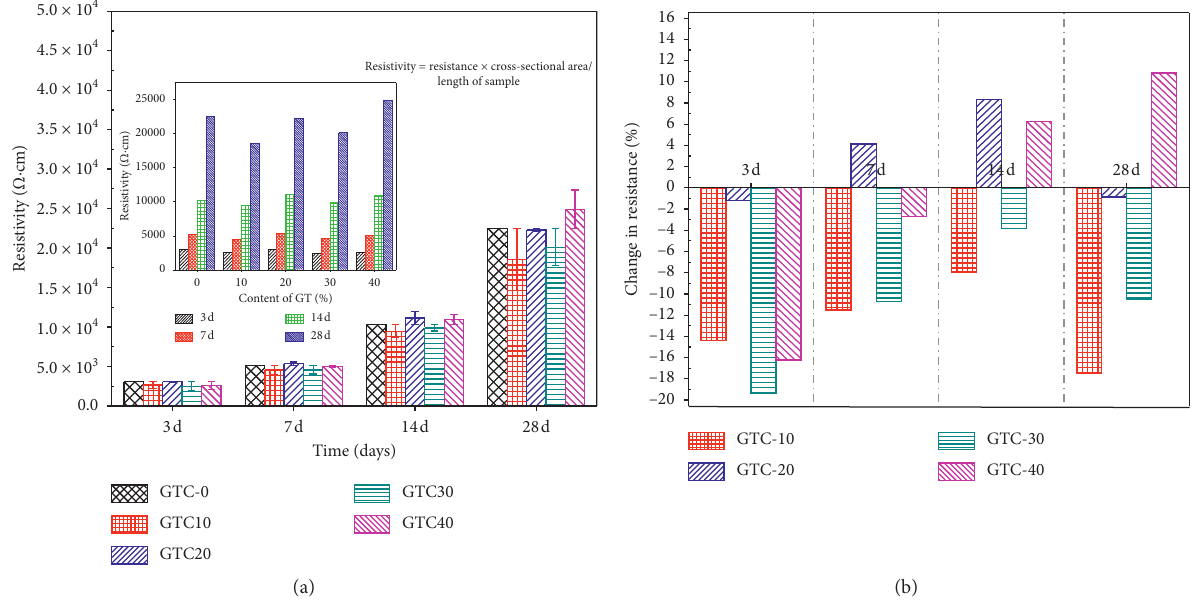
Figure 5: Resistivity properties of GTC (0% to 40%) in different curing